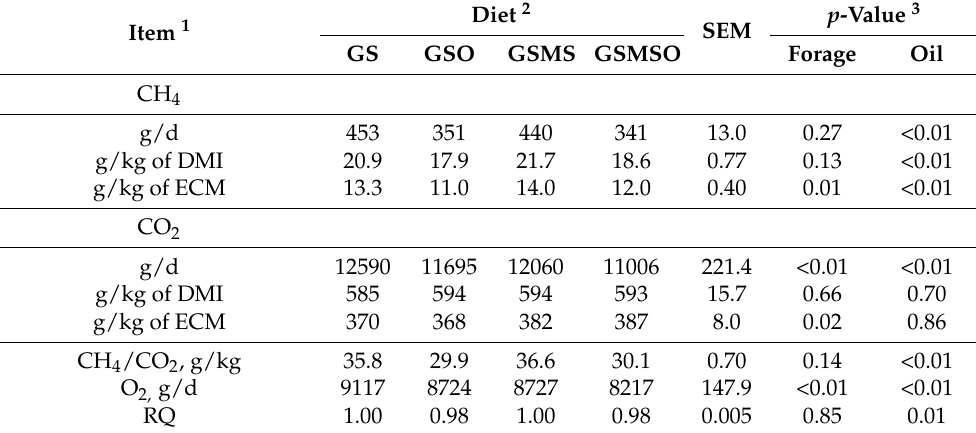
Table 5. Methane (CH 4 ), carbon dioxide (CO 2 ) emissions and oxygen (O 2 ) consumption for cows fed the experimental diets ( n = 20).